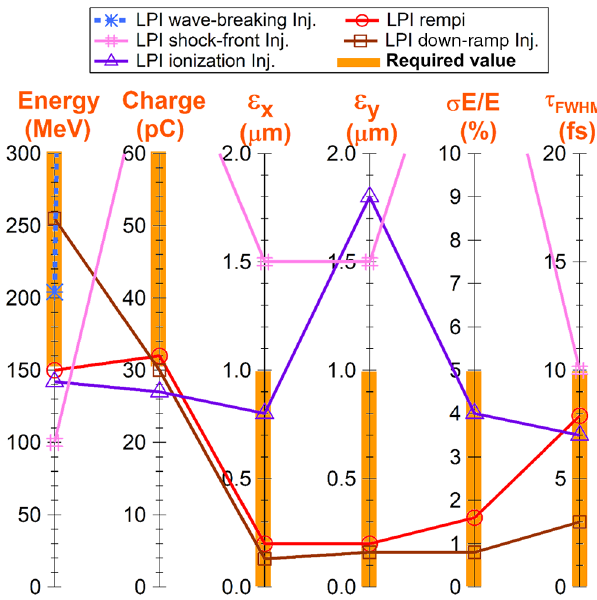
FIG. 2. Beam parameters obtained at the 150 MeV LPI exit compared to the requirements for five different injection techniques.